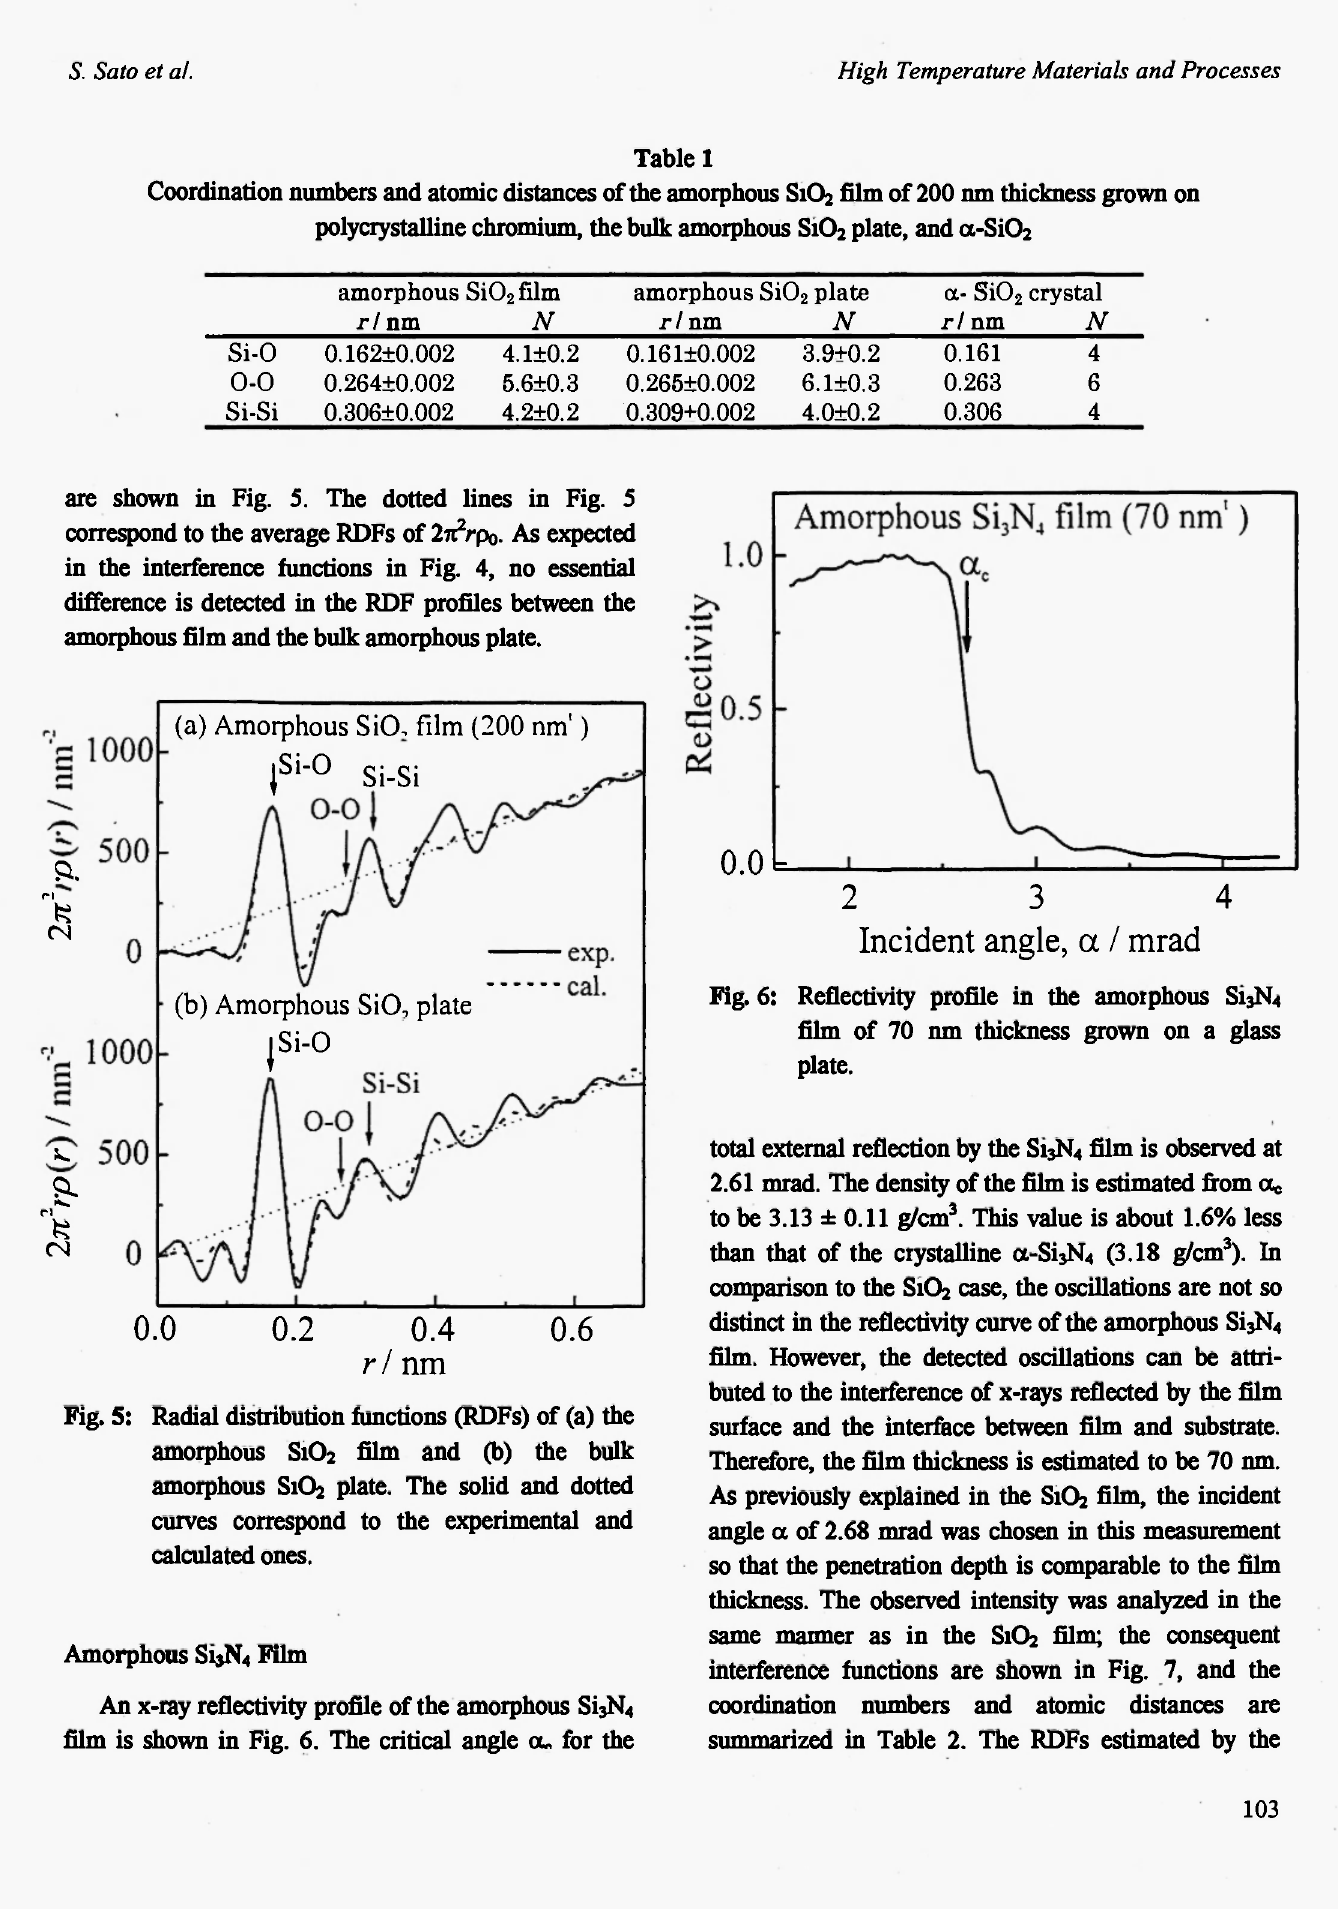
Coordination numbers and atomic distances of the amorphous S1O2 film of 200 nm thickness grown on polycrystalline chromium, the bulk amorphous S1O2 plate, and a-Si02